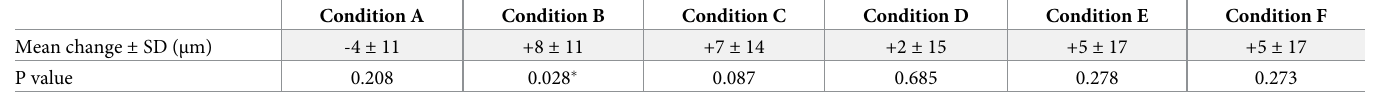
Table 2. Mean change in subfoveal choroidal thickness from baseline across different defocus conditions in all